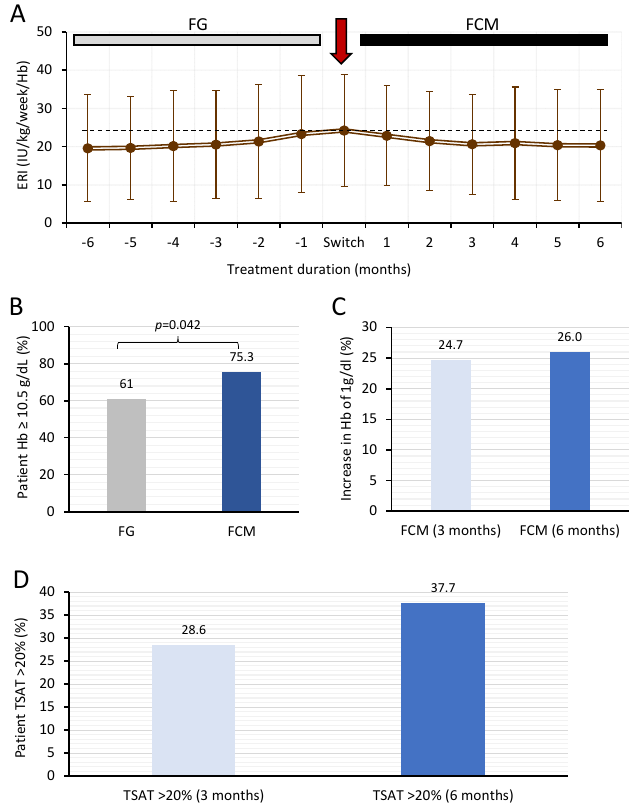
Figure 2. Primary efficacy measures in hemodialysis patients who switched from FG to FCM. ( A ), change in ERI during FG and FCM treatments over the 12 months. ( B ), the proportion of patients (%) achieving hemoglobin levels ≥ 10.5 g/dL during FG and FCM treatments; ( C ), the proportion of patients (%) showing a 1 g/dL increase in hemoglobin levels at 3 and 6 months of FCM treatment; ( D ), the proportion of patients (%) achieving levels of TSAT >20% at 3 and 6 months of FCM treatment. ERI data are presented as mean ± SD whereas all other data are presented as %. Dotted line represents ERI at the switch visit. ERI = erythropoietin resistance index, FCM = ferric carboxymaltose, FG = ferric gluconate, TSAT = transferrin saturation.